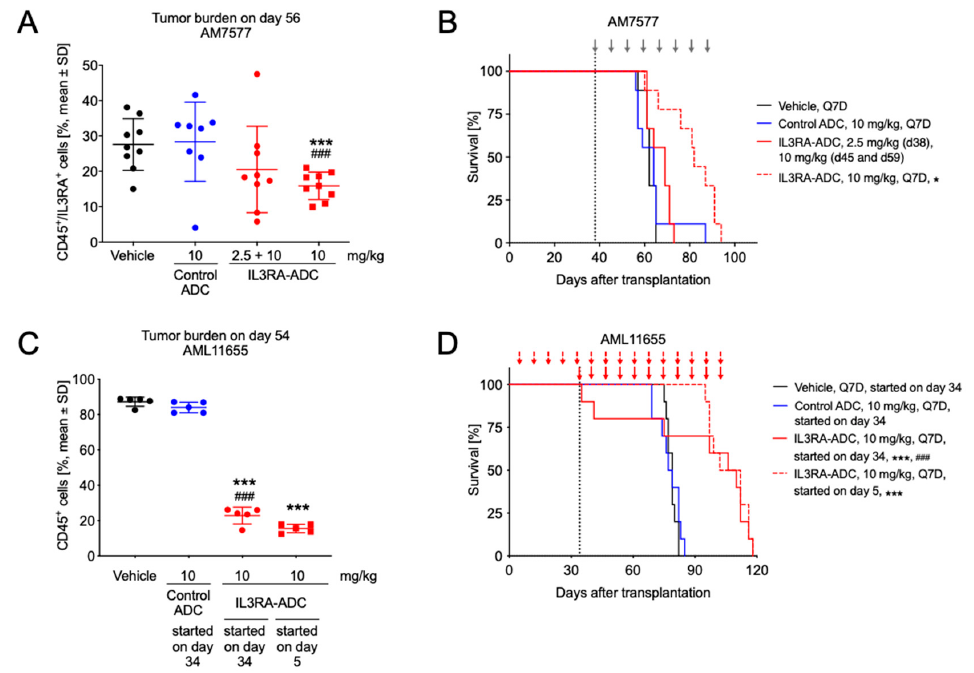
Figure 3. Antitumor e ffi cacy of the IL3RA-ADC BAY-943 in the patient-derived AM7577 and AML11655 AML xenograft models. ( A ) Tumor burden on day 56 in mice transplanted with AM7577 cells and treated i.p. with the isotype control ADC (10 mg / kg, Q7D) and IL3RA-ADC (2.5 + 10 mg / kg or 10 mg / kg, Q7D). In the 2.5 + 10 mg / kg IL3RA-ADC treatment group, the first dose was 2.5 mg / kg (day 38) and the two subsequent doses (on days 45 and 59) 10 mg / kg. ( B ) Kaplan–Meier survival plots of mice described in panel A. Treatment days in all groups except for the 2.5 + 10 mg / kg IL3RA-ADC treatment group are indicated with gray arrows. ( C ) Tumor burden on day 54 in mice transplanted with AML11655 cells. Intraperitoneal treatments with the isotype control ADC (10 mg / kg, Q7D) were initiated on day 34 and with IL3RA-ADC (10 mg / kg, Q7D) on day 5 (preventive setting) or 34 (therapeutic setting). ( D ) Kaplan–Meier survival plots of mice described in panel C. Treatment days are indicated with red arrows. The data were analyzed using the Cox proportional-hazards model and corrected for family-wise error rate using Sidak’s method. Asterisks and hashtags indicate statistical significance in comparison to vehicle (* p < 0.05, *** p < 0.001) and the isotype control ADC (### p < 0.001).